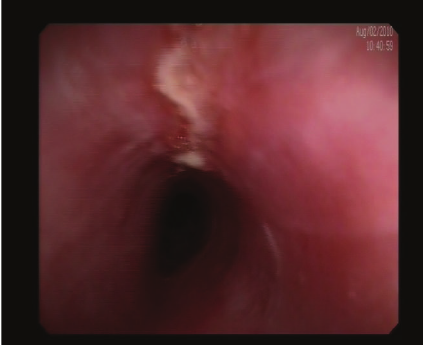
Figure 1: Esophageal ulcerations.